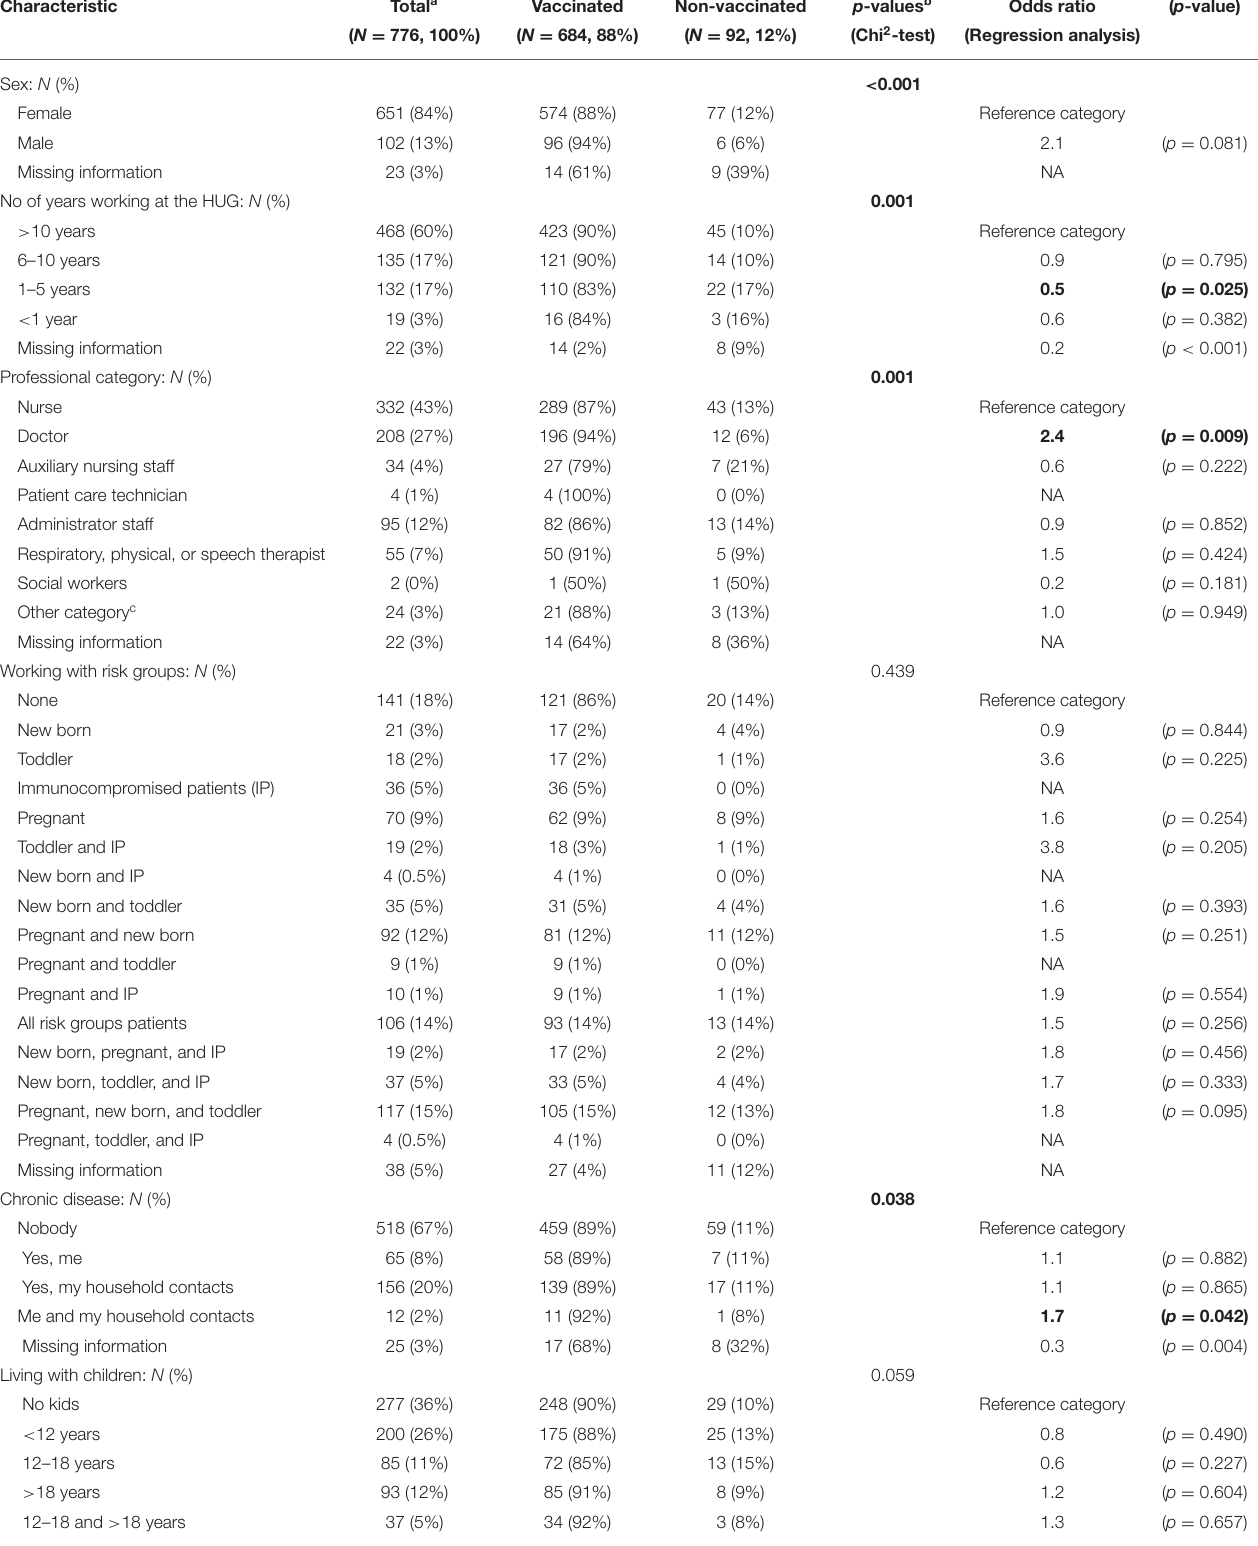
TABLE 1 | Characteristics of the study population. Characteristic Total a Vaccinated Non-vaccinated p -values b Odds